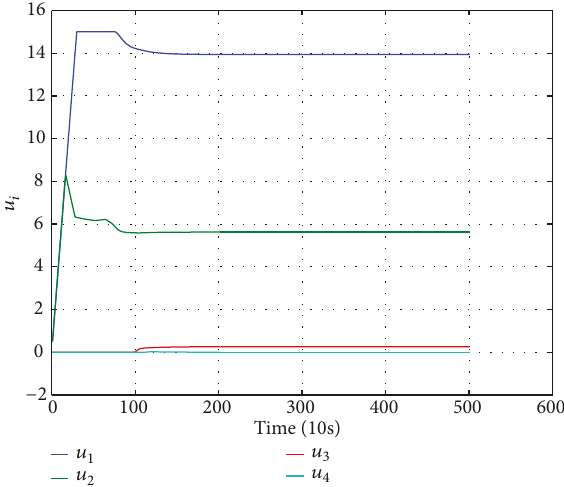
Figure 3: The variation curve of system input when the load of generator unit is 400MW, 𝑢 𝑗 ∈ [0,15], Δ𝑢 𝑗 = 0.5